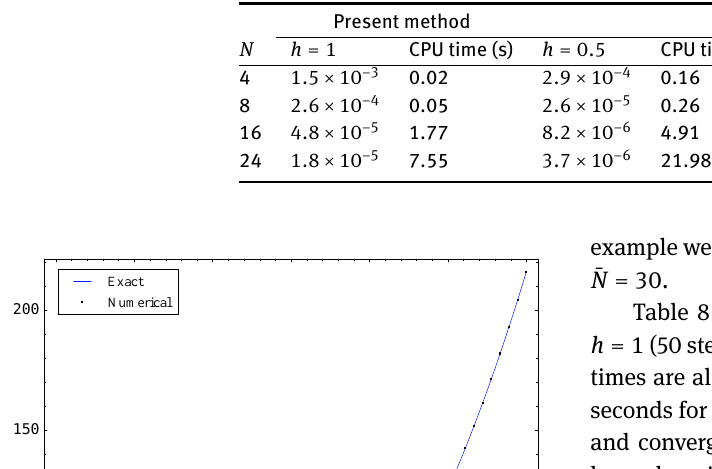
Table 7: Comparison of maximum absolute errors on the interval [0, 1] for α = 2.5, β = 0.9, γ = 1.5 for Example 4.